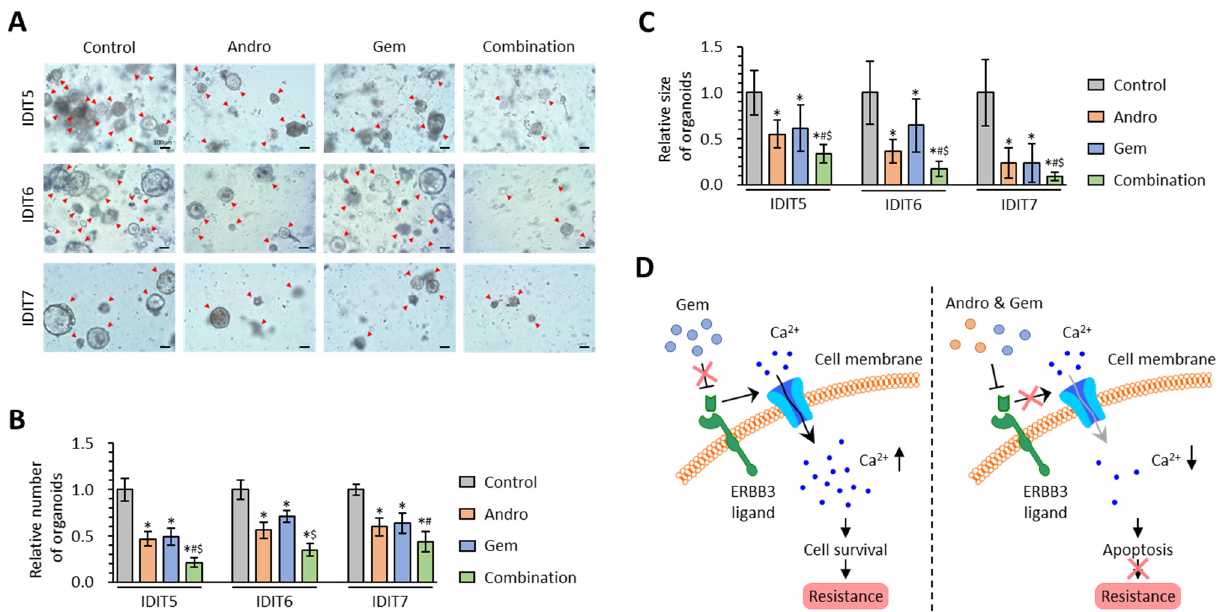
Figure 6. The combination of Andrographis and Gemcitabine effectively enhances anti-cancer activity in PDAC patient-derived organoid models. ( A ) Representative images of tumor organoids following treatment with Andro, Gem, and their combination. Scale bar = 100 μ m (Magnification 100 × ). ( B , C ) Bar charts of relative number ( B ) and size ( C ) of tumor organoids following treatment with Andro, Gem, and their combination. The average (column) ± SD is indicated (* p < 0.05 vs. control, # p < 0.05 vs. Andro, $ p < 0.05 vs. Gem). ( D ) A schematic illustration of Andro-mediated reversal of Gem resistance in PDAC. This illustration demonstrates Gem resistance through ERBB3 ligand-dependent calcium influx in PDAC cells (left) and the role of Andro in reversing Gem resistance through regulation of calcium signaling in PDAC cells (right). PDAC, pancreatic ductal adenocarcinoma; Gem-R, Gemcitabine-resistant; Andro, Andrographis; Gem, Gemcitabine; SD, standard deviation; Ca, calcium.